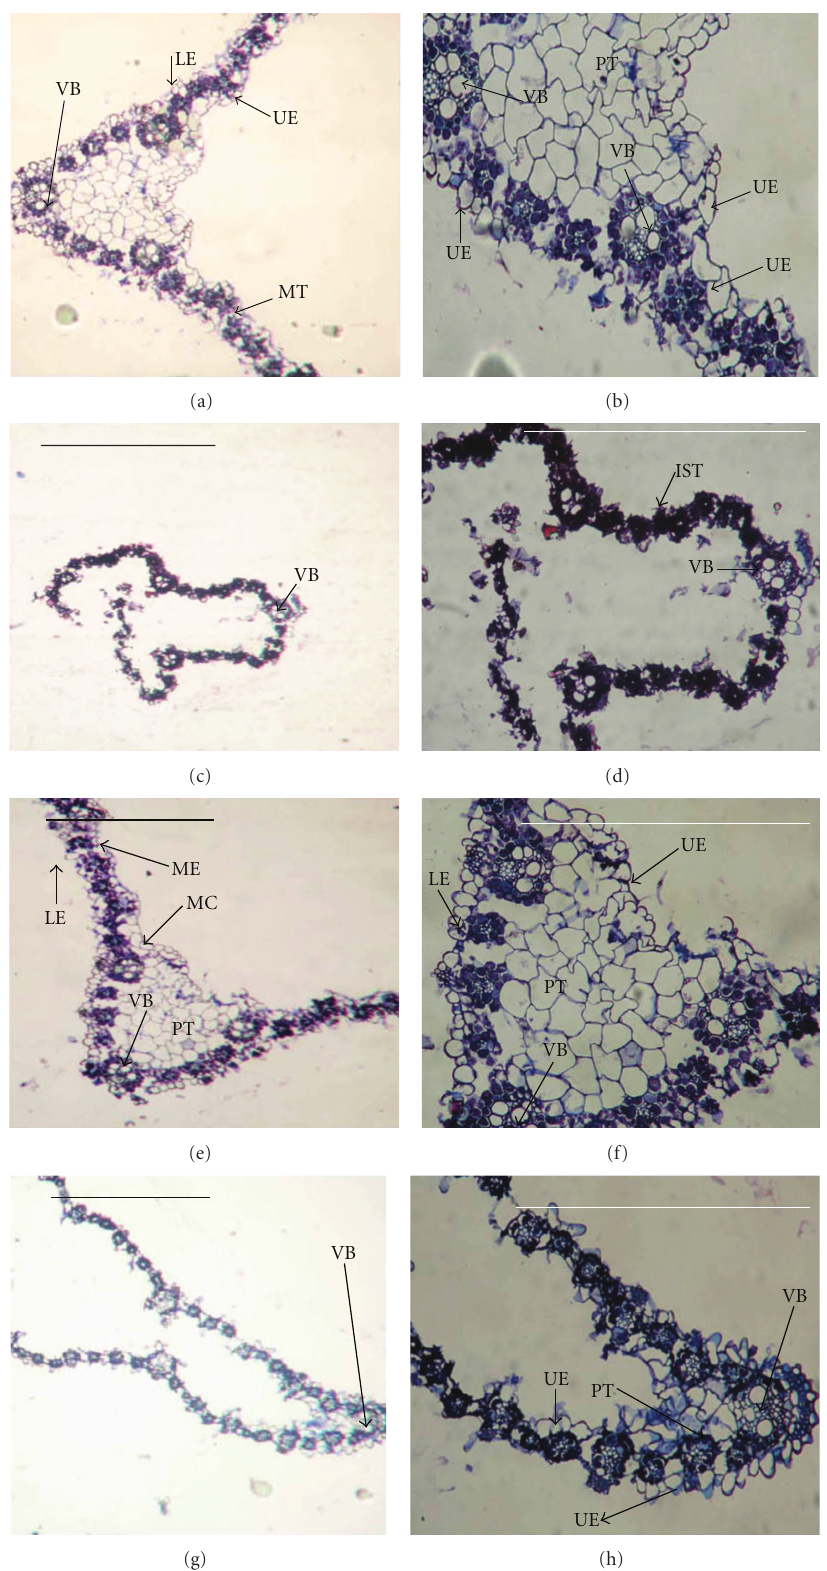
Figure 1: Cross-sections through the lamina of untreated susceptible biotype (a, b), treated susceptible biotype (c, d), untreated resistant biotype (e, f), and resistant biotype treated with fenoxaprop-p-ethyl (g, h) of E. crus-galli after 14 days. ∗ Upper epidermis (UE), lower epidermis (LE), parenchyma tissue (PT), mesophyll tissue (MT), motor cells (MC), vascular bundle (VB), and intensive stained tissue (IST); Bar = 500 µ